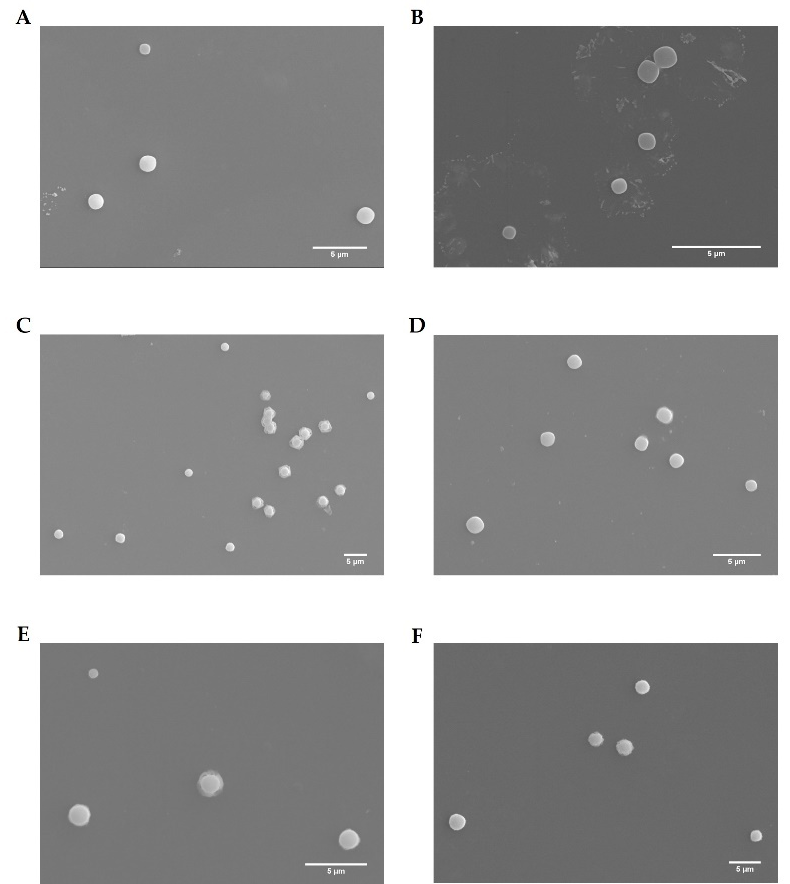
Figure 3. Scanning electron micrographs of WRPA5/pDNA complexes at N/P ratios of 0.5 ( A ) and 1 ( B ), Tf-WRAP5/pDNA complexes at N/P ratios of 0.5 ( C ) and 1 ( D ), and TMZ/WRAP5/pDNA ( E